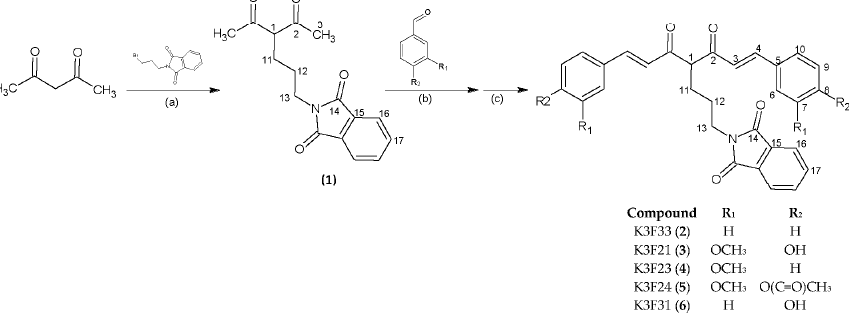
Figure 1. General scheme for the synthesis of phthalimide-based curcuminoids. ( a ) K 2 CO 3 /KI, dry acetone, 80 °C, 24 h; ( b ) B 2 O 3 , tributylborate, n-butylamine, DMF, 80 °C, 6 h; ( c ) 0.5 M HCl, 80 °C, 1 h.